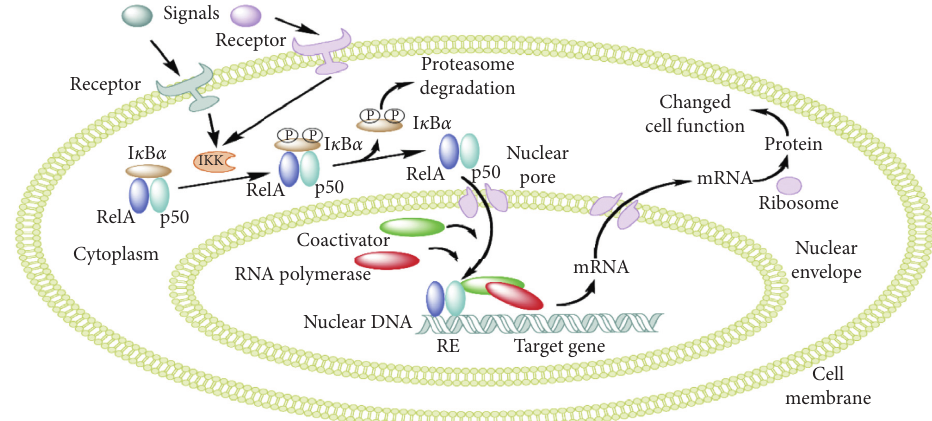
Figure 2: Mechanism of phage action in bacterial cell (Wikimedia Commons. Retrieved 17:38, August 29, 2020, from https://commons. wikimedia.org/w/index.php?title � File:NFKB_mechanism_of_action.png&oldid �